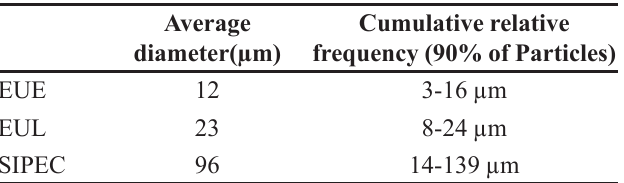
TABLE II - Particle size and distribution obtained from